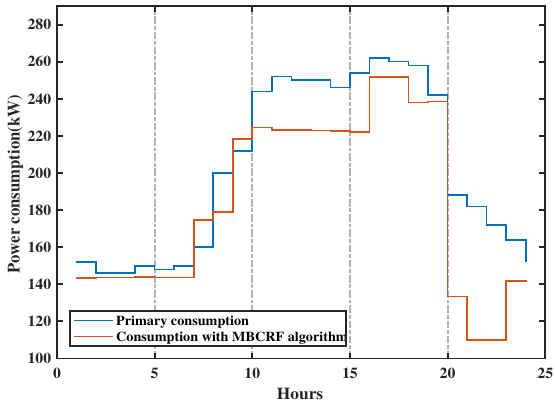
Figure 10. Power consumption for the scheduling horizon of one day.